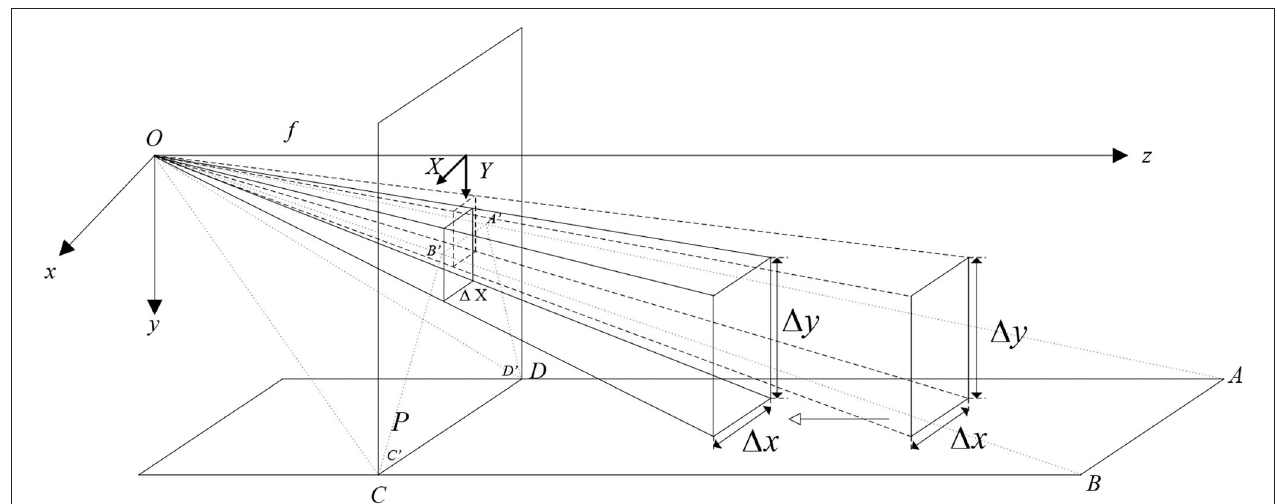
FIGURE 5 | Demonstration of the perspective